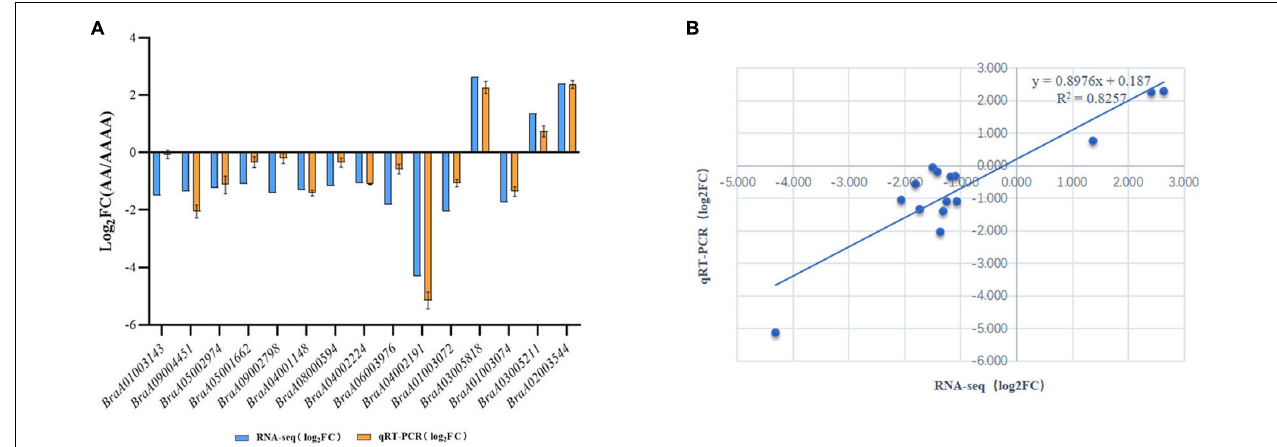
FIGURE 6 | The heat map of gene expression screened by the integrative analysis of RNA-seq and Hi-C. (A) The gene expression heatmap of down-regulated DEGs in autotetraploid pak choi involved in A-to-B compartment and up-regulated DEGs involved in B-to-A compartment. (B) The gene expression heatmap of down-regulated DEGs in diploid pak choi in repressed TADs and up-regulated DEGs in activated